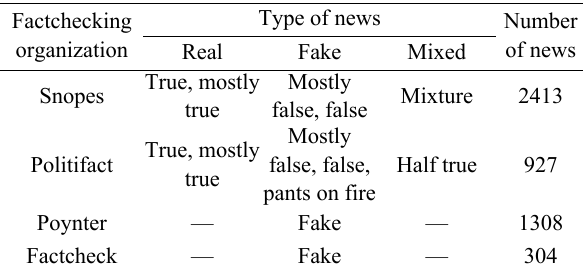
Table 2 News types based on the classifications of four factchecking organizations.